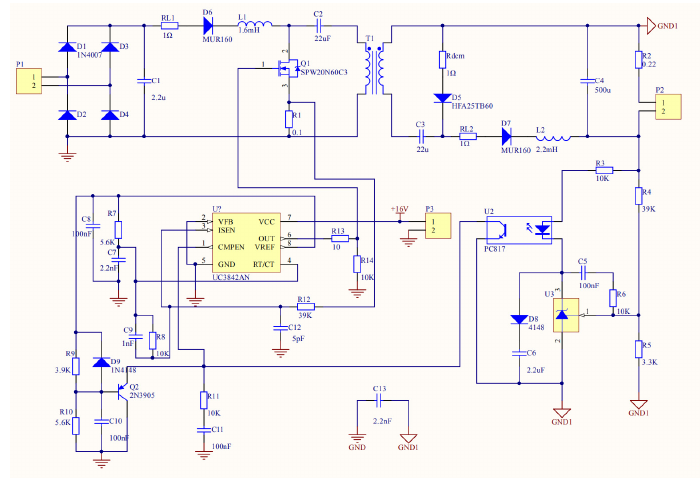
Figure 16. System circuit diagram.